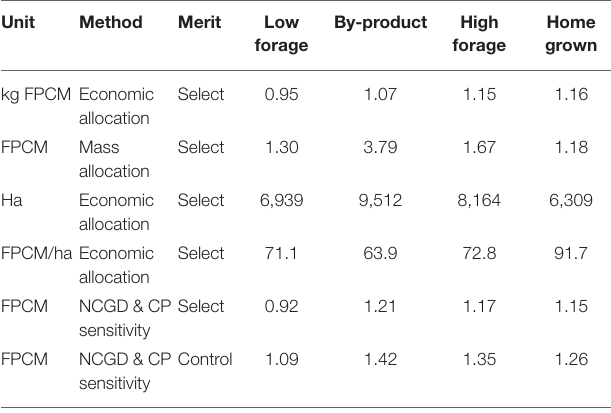
TABLE 10 | Dairy system mean GHG emissions (kg CO 2 e) per functional unit.